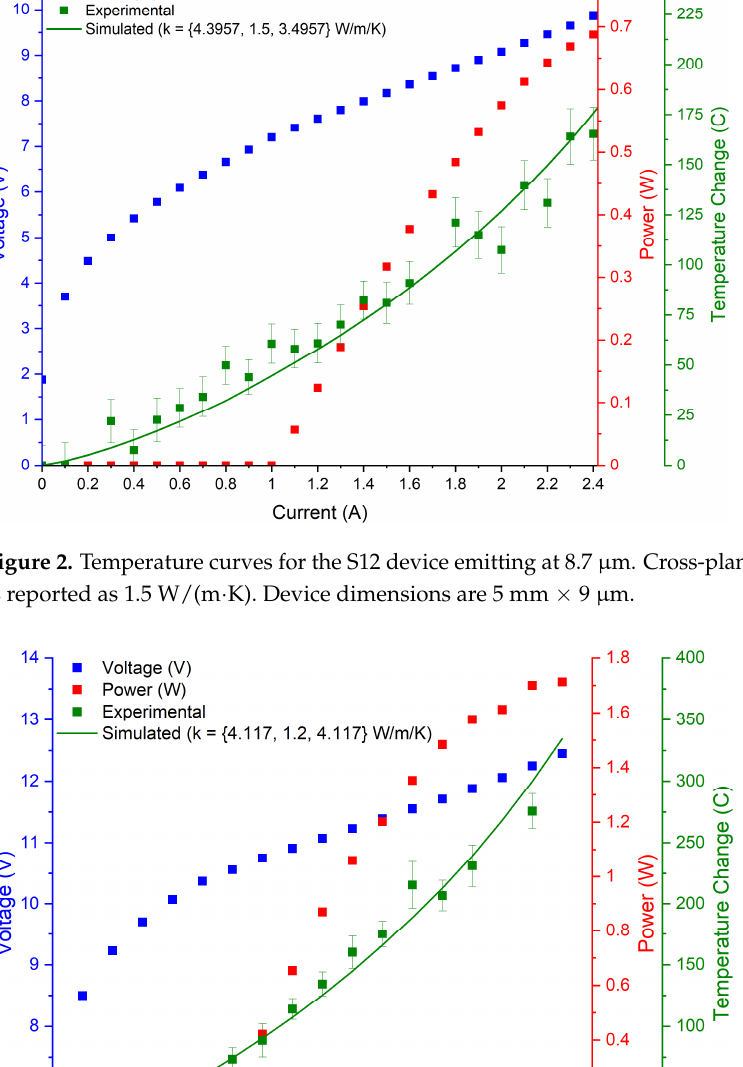
Figure 4. Temperature curves for S25 device emitting at 3.7 μ m. Cross-plane thermal conductivity is reported as 0.9 W/(m·K). Device dimensions are 5 mm × 7.2 μ m.